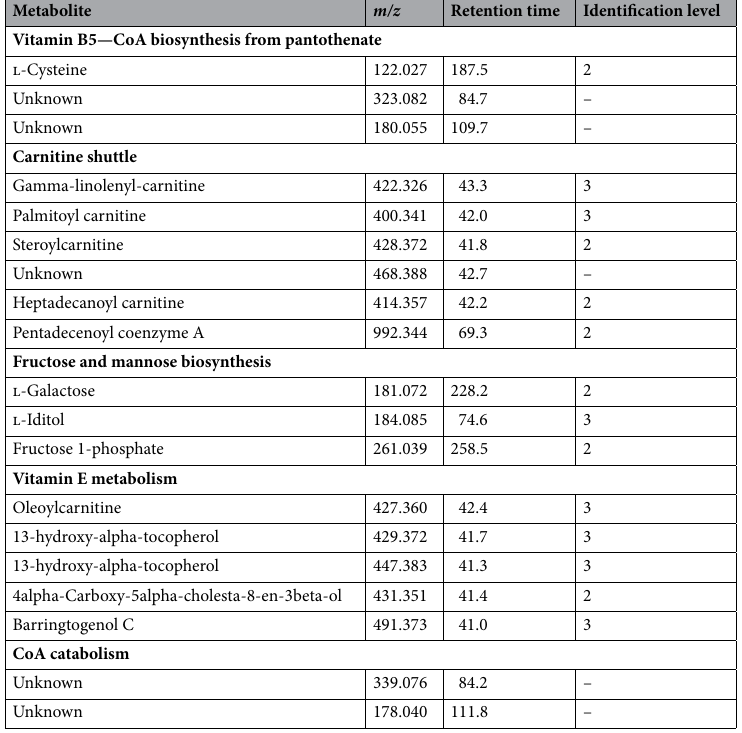
Table 2. Significant metabolites identified in the other five significant pathways leading to liver transplantation rejection.